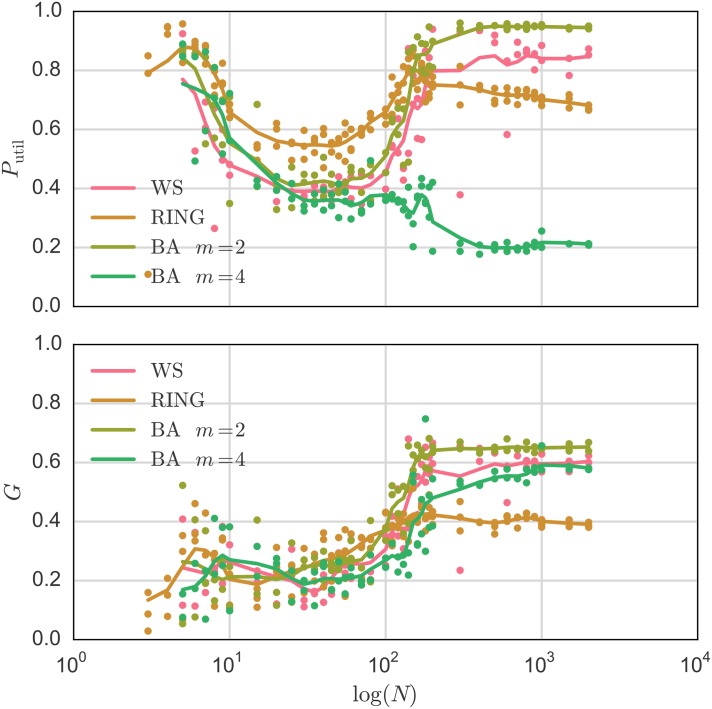
Power utilization Putil (top) and Gini index G (bottom) as a measure of inequality of power distribution, where G = 1 representing the biggest inequality.The Watt-Strogatz-Graph (WS) setting is: mean degree K = 4, rewiring probability β = 0.5. Barabasi-Albert-Graph (BA) setting is: number of nodes to attach to m = 2,4. The system parameters are: λmin = 0.005, RV = 2Ω, R0 = R/N = 200Ω, perr = 0.01 and V = 1 V.